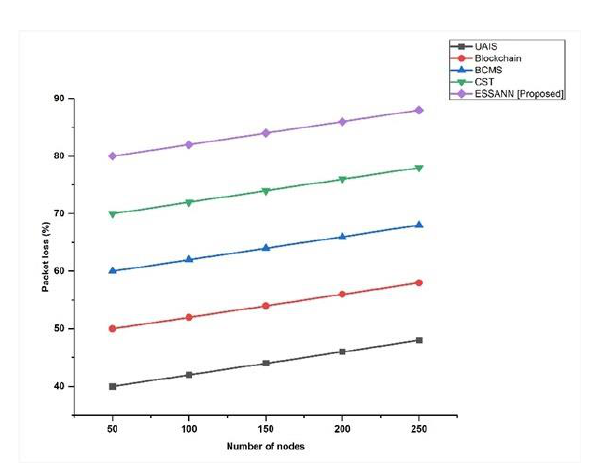
Figure 7. Comparison of Packet loss [23 – 26].